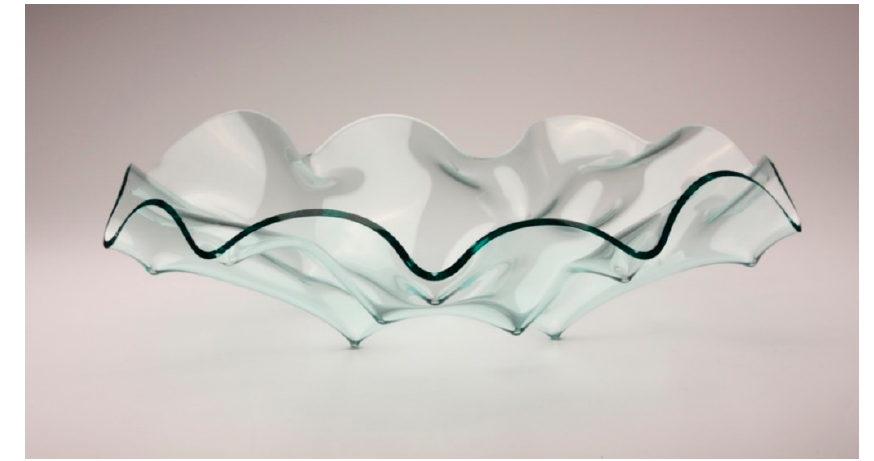
Figure 13. Clear Pin Bowl (2013) by the author, (photo: Jorgensen, T. 2013). Funding: This research received no external funding.